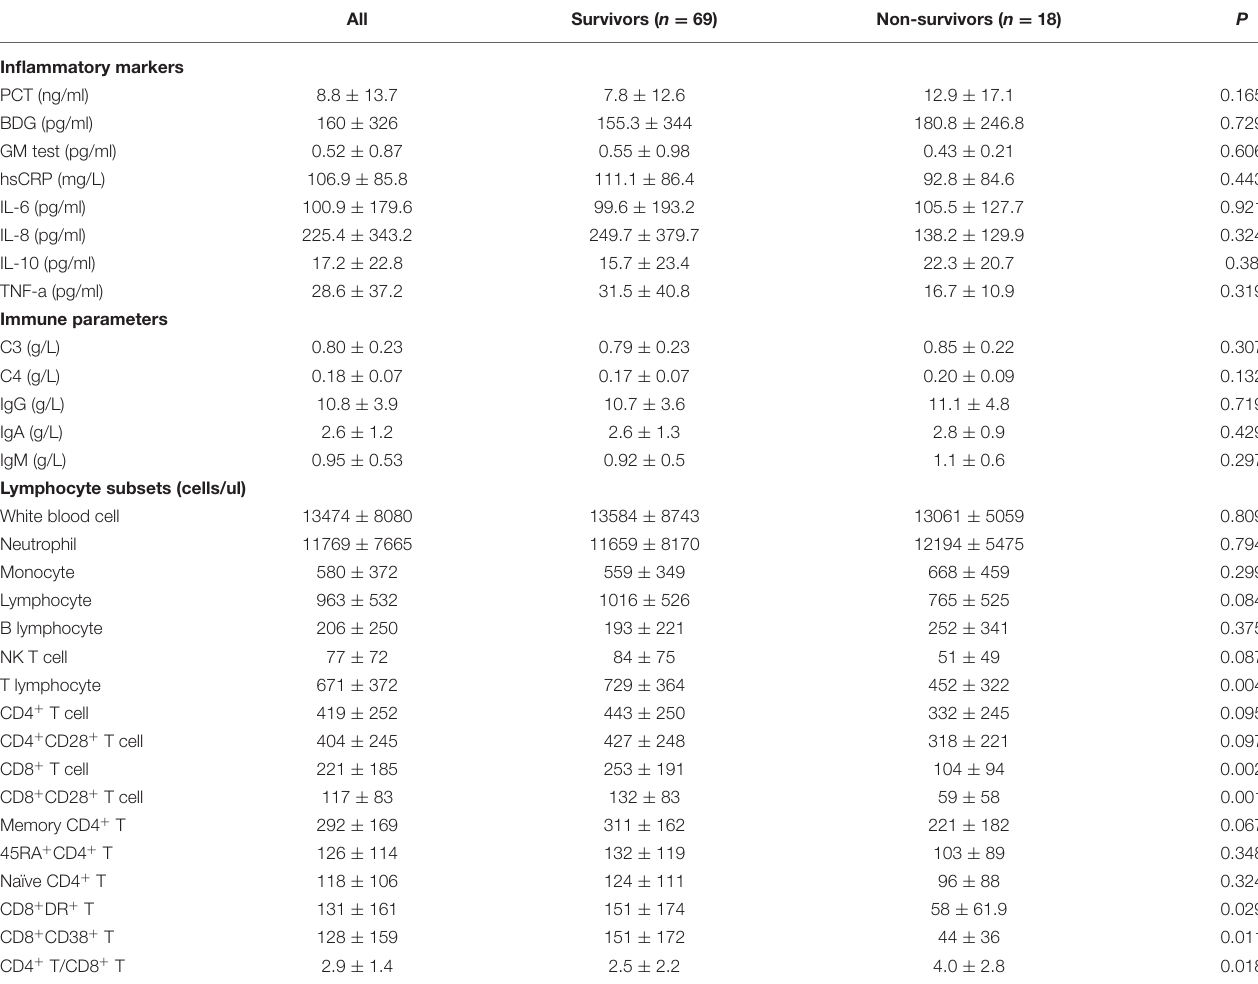
TABLE 3 | Inflammatory and immune related markers of ARDS caused by A. baumannii pneumonia.